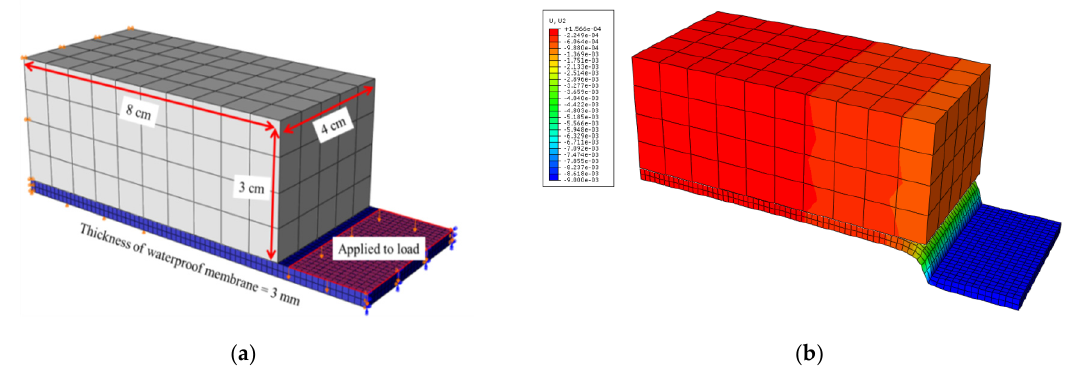
Figure 8. Linear block support test: ( a ) model and ( b ) visualization of uniform vertical displacement.